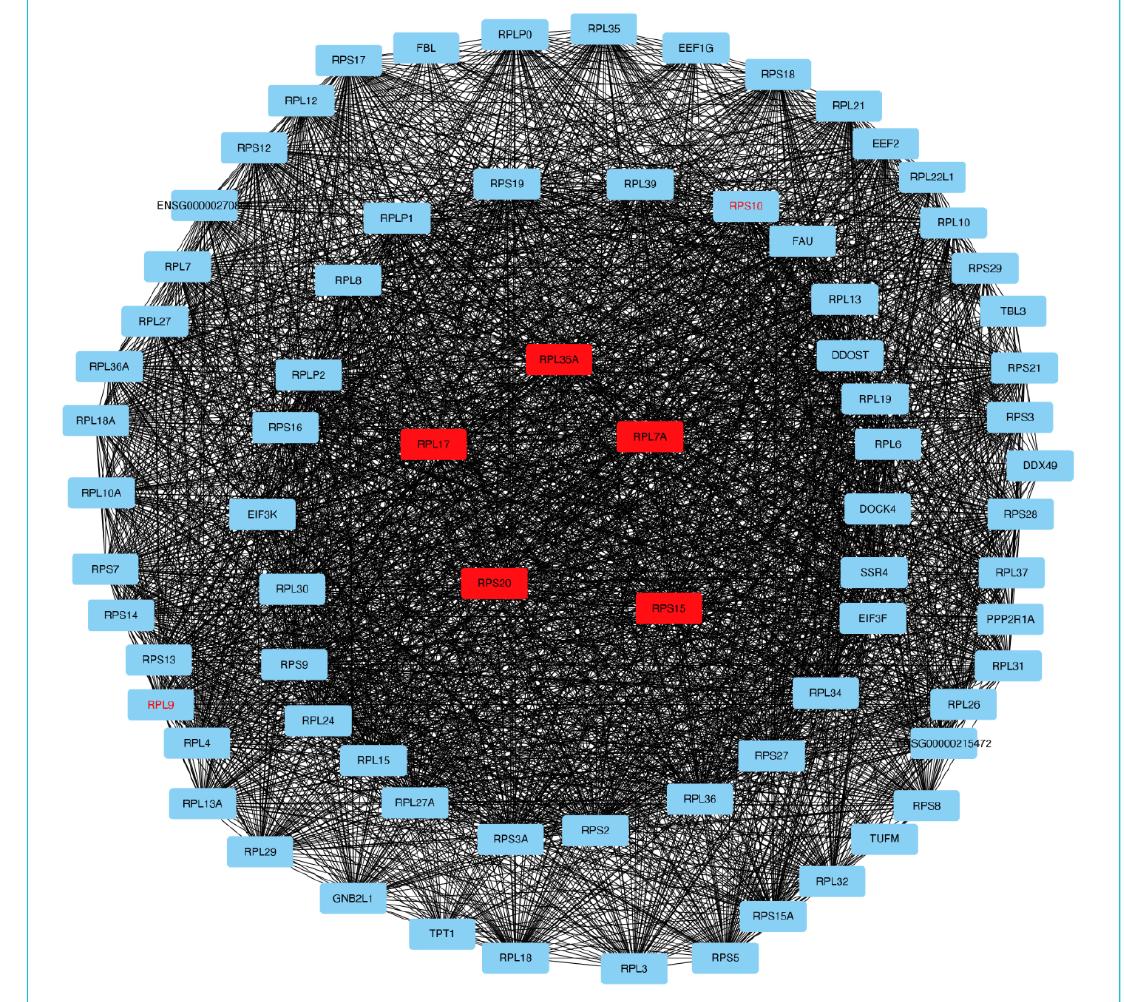
Figure 6: Protein–protein interaction network of the DEGs in the yellow and grey modules. Abbreviations: DEG, differentially expressed